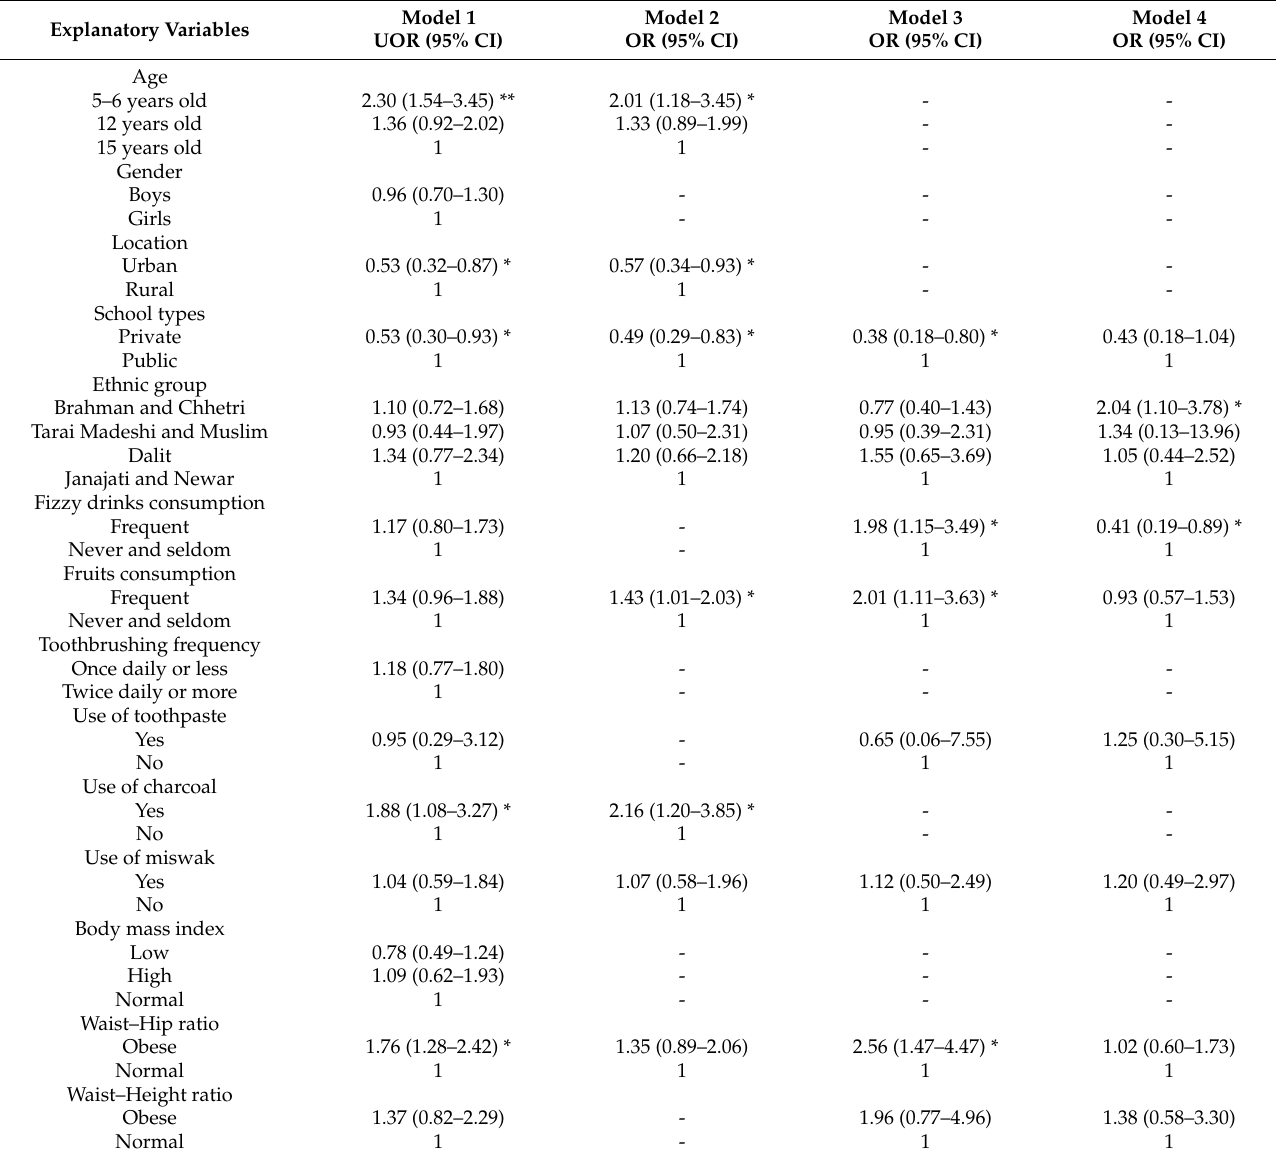
Table 3. Association between erosive tooth wear (sum score 0–2/ ≥ 3) and explanatory variables (age, gender, location, school types, ethnic group, fizzy drinks consumption, fruits consumption, toothbrushing frequency, use of toothpaste, use of charcoal, use of miswak, body mass index, waist–hip ratio and waist–height ratio) using logistic regression